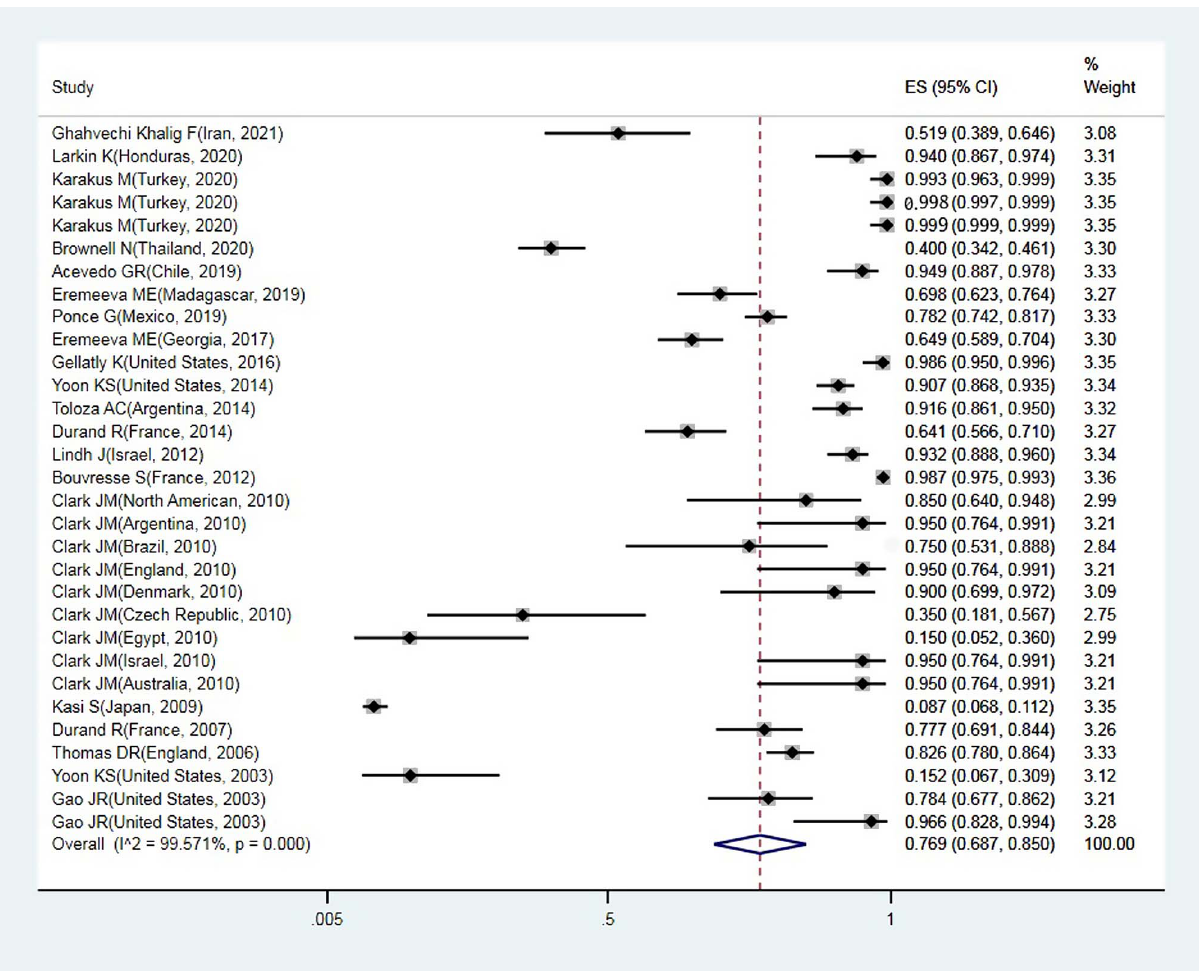
Figure 2. Forest plots of the proportion of resistance in lice and 95% con fi dence interval based on a random effect model in